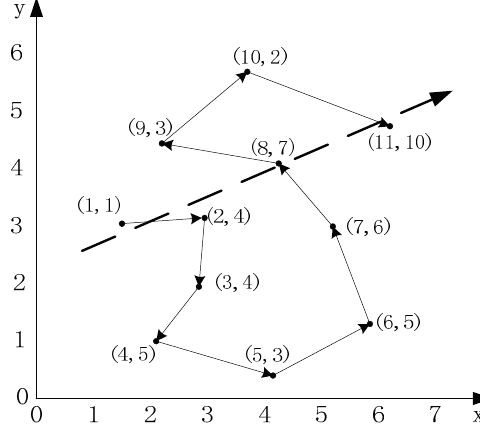
Figure 4. The route of a RW Mode token.